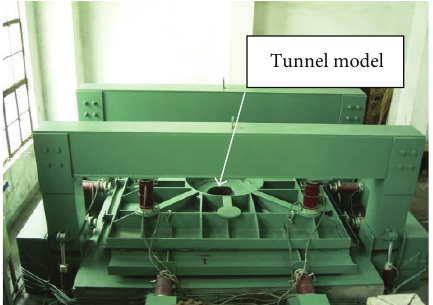
Figure 8: Tunnel-ground complex simulation